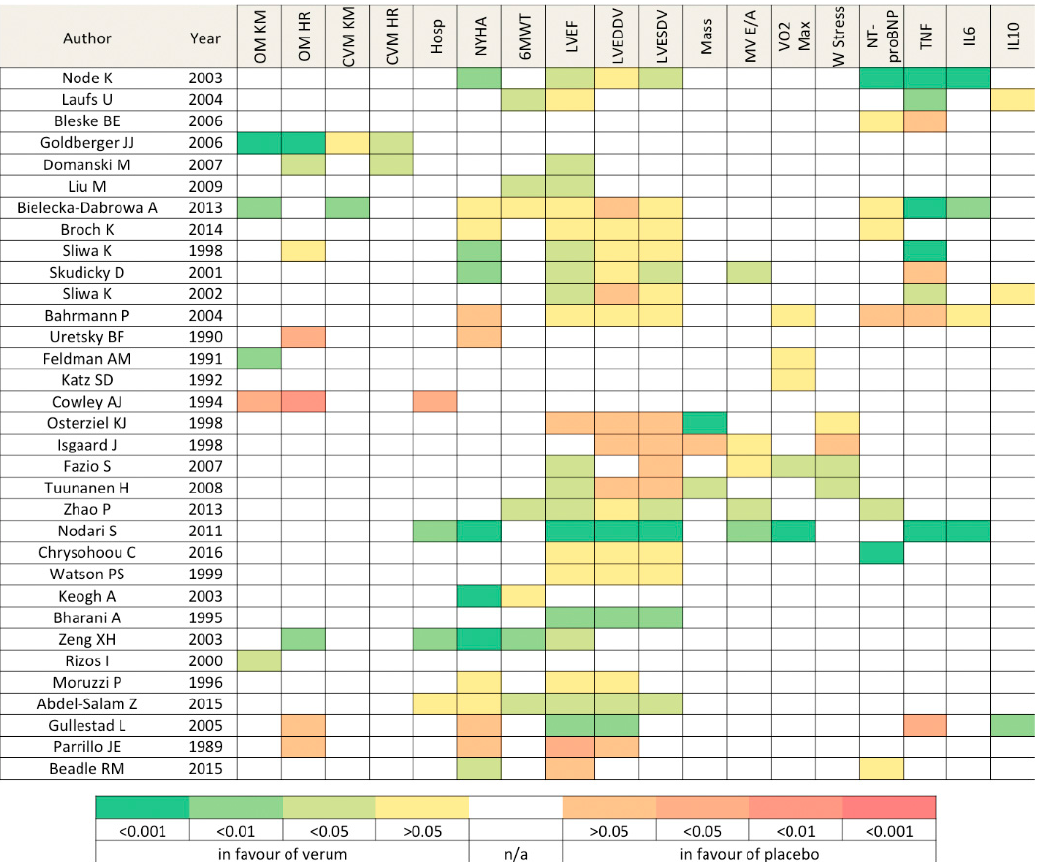
Figure 3. Heatmap reporting statistical significance of molecular results, morphofunctional parameters, and clinical endopoints in 33 clinical studies. Abbreviations—(OM KM) overall mortality Kaplan-Meier, (OM HR) overall mortality Hazard Ratio, (CVM KM) cardiovascular mortality Kaplan-Meier, (CVM HR) cardiovascular mortality Hazard Ratio, (Hosp) hospitalization, (NYHA) NYHA functional class, (6MWT) 6-min walking test, (LVEF) left ventricle ejection fraction, (LVEDDV) left ventricle end-diastolic dimension/volume, (LVESDV) left ventricle end-systolic dimension/volume, (Mass) Cardiac Mass, (MV E/A) Mitral valve E/A ratio, (VO2 Max), maximum oxygen uptake, (W Stress) wall stress.